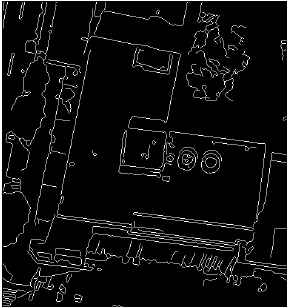
Figure 6. Results of 3D Coordinates by CLR